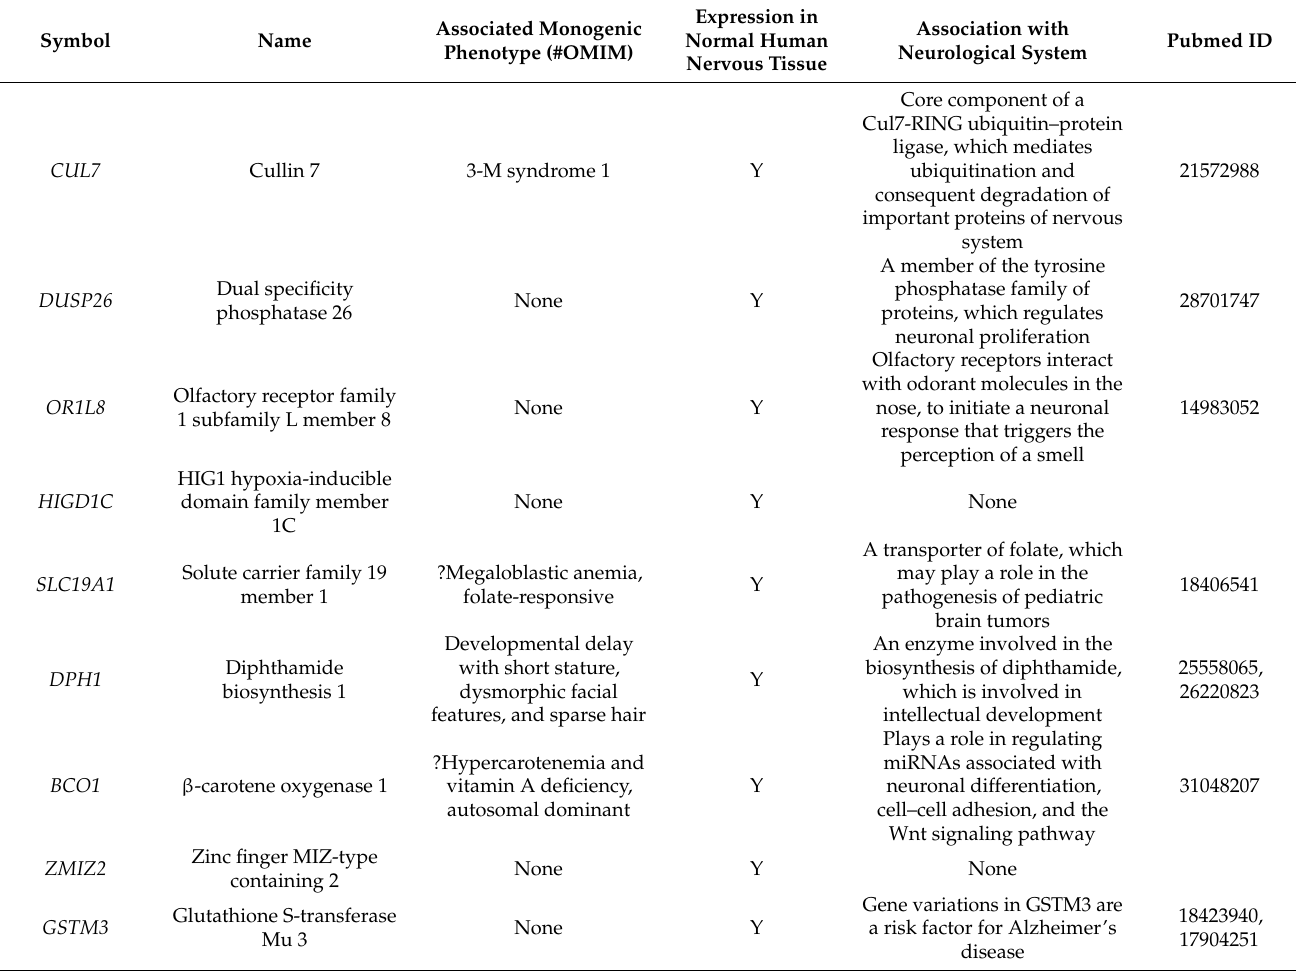
Table 2. The 36 identified candidate modifier genes of neurological involvement in